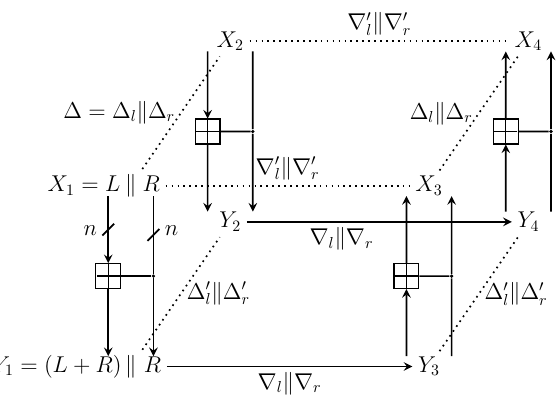
Figure 3: A boomerang switch on a modular